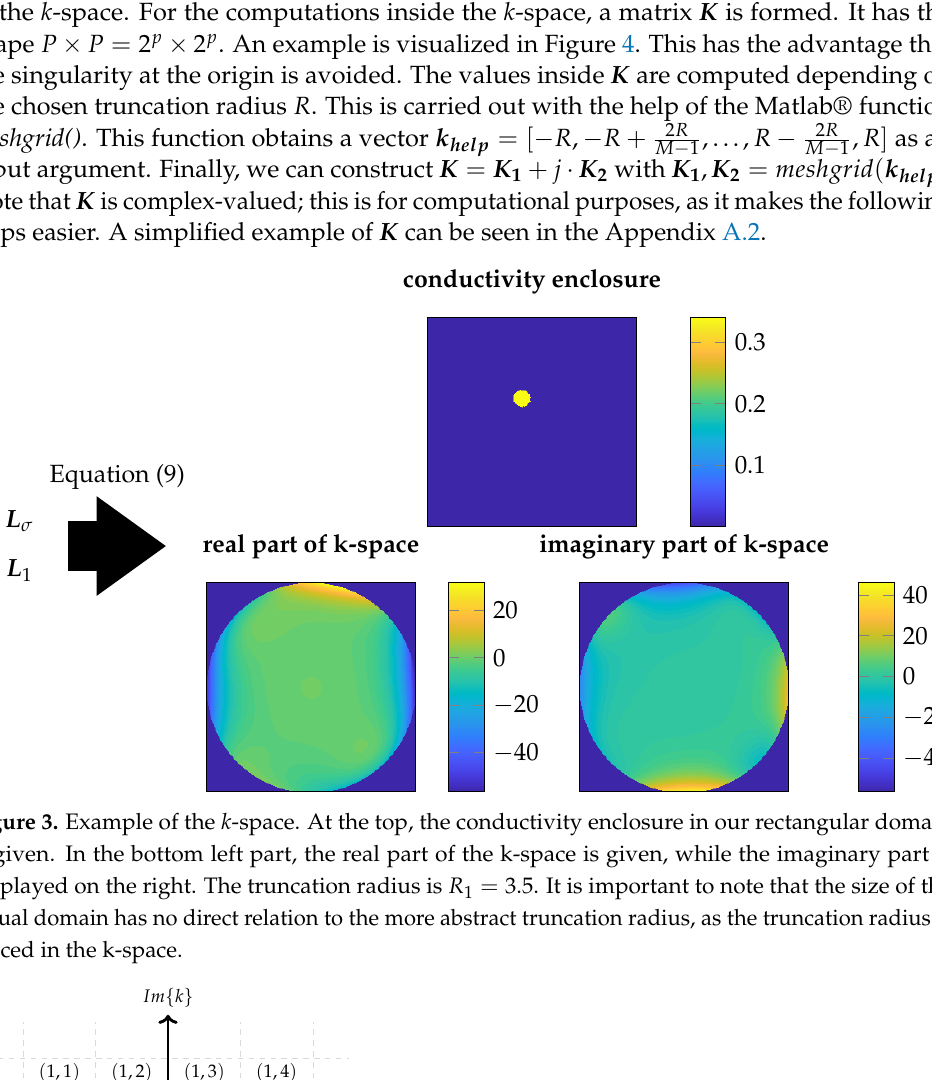
Figure 3. Example of the sample strategy of K for p = 2 which results in a 4 Figure 4. Example of the sample strategy of K for p = 2 which results in a 4 just for illustration purposes and would be too low for computations). Every quadrant of the k -space has the same number of points. The numbers above the points are the indices of the matrix K as implemented in Matlab®. represents a function through sinusoidal waves, the scattering transform represents the input via non-linear waves. t exp ( k ) is only evaluated for values of called the truncation radius. This is due to the fact, that high values of instabilities. An example of the k -space for a specific conductivity enclosure and can be observed in Figure ?? .